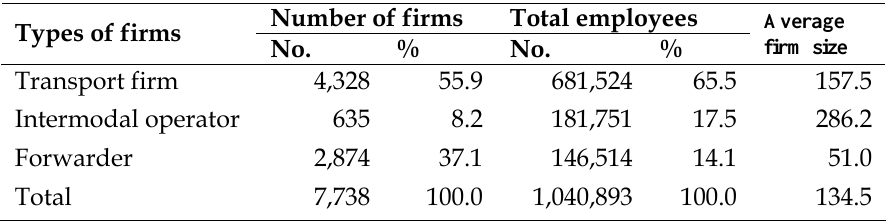
Table 3. Employment distribution by types of firms Number of